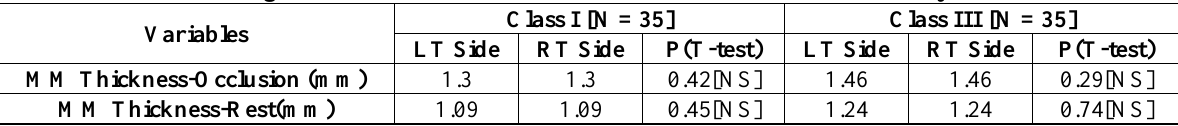
Table 3: Right to Left Side Differences in MM Thickness Stratified by Classes Variables